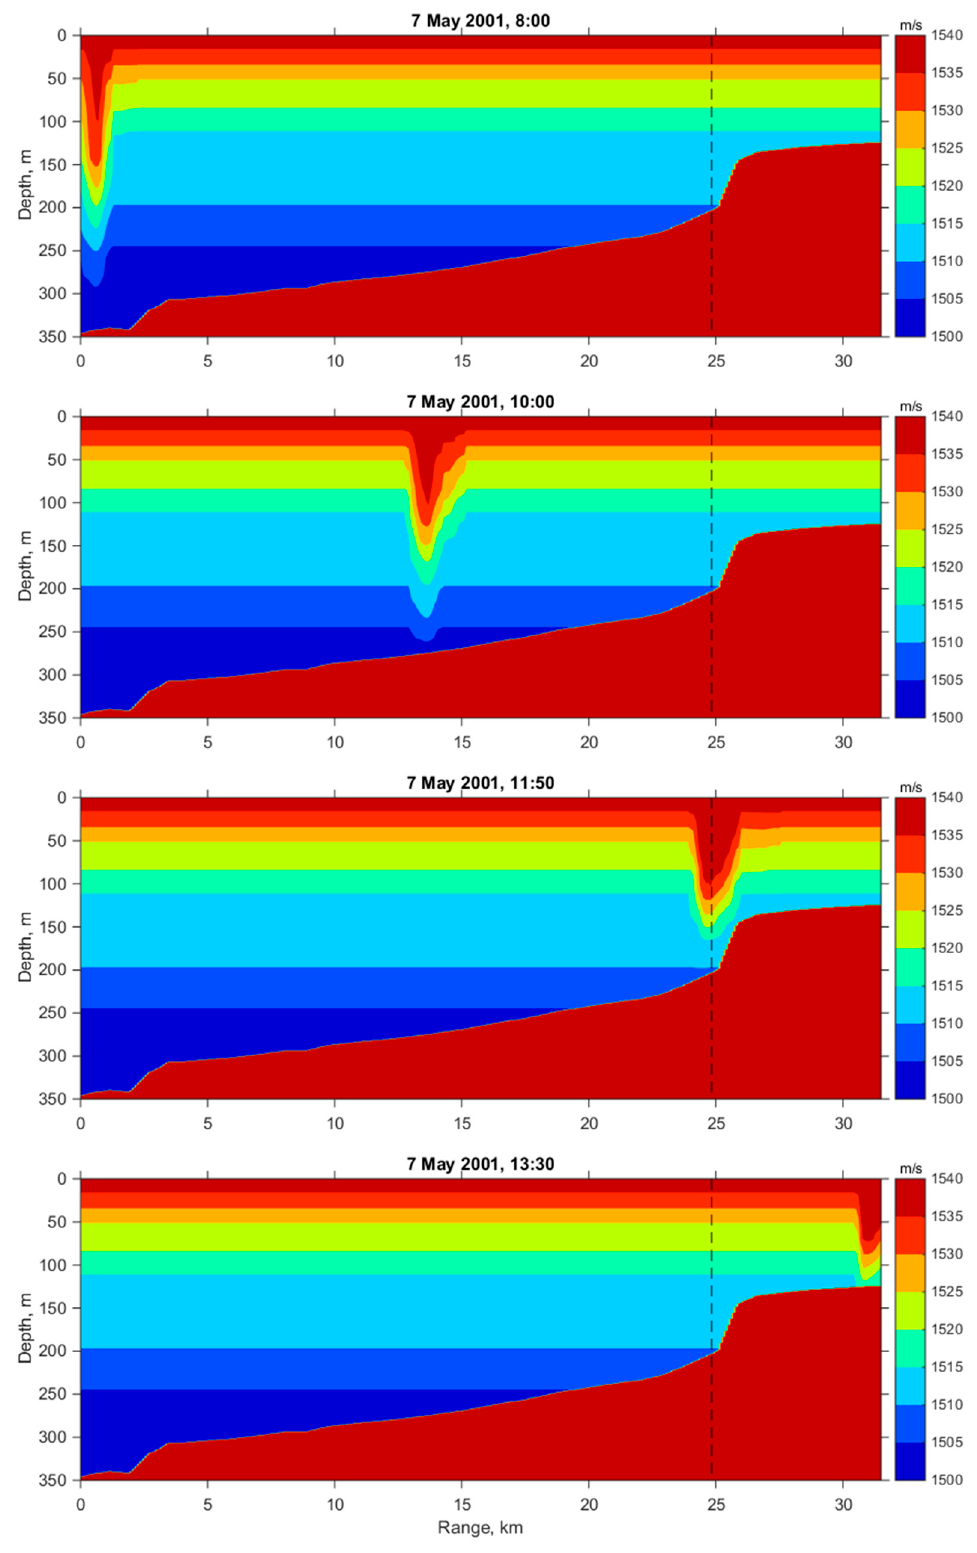
Figure 7. Reconstruction of the sound speed field. Dashed lines denote positions of E2. Each panel shows position of NIW at the time moment indicated above the panel.